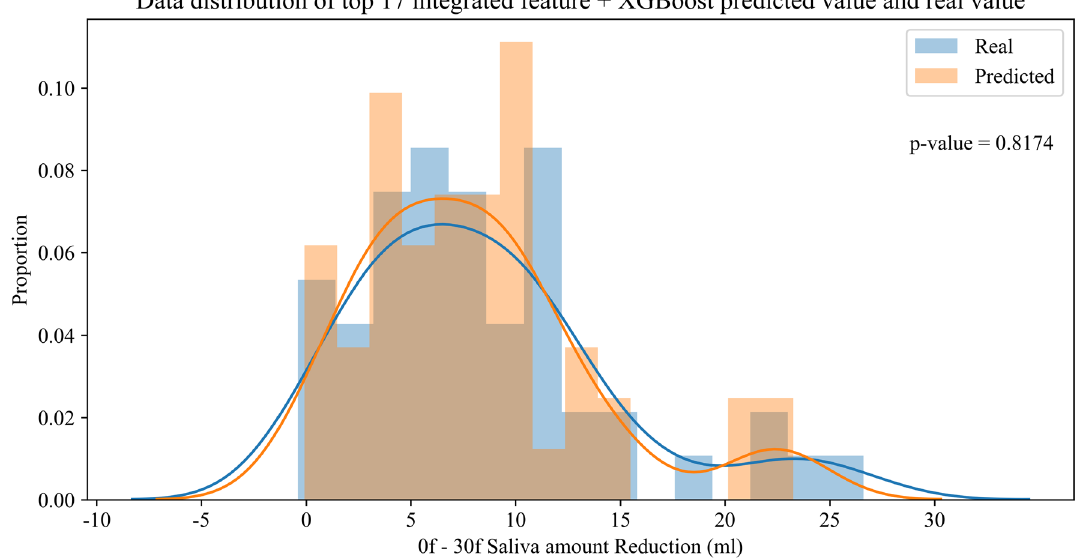
Fig. 5 Top 17 integrated features_XGBoost predicts the SA